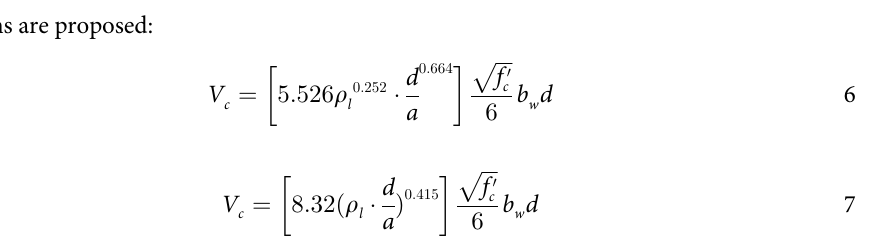
Fig 2. Shear strength of HSC beams (Eq